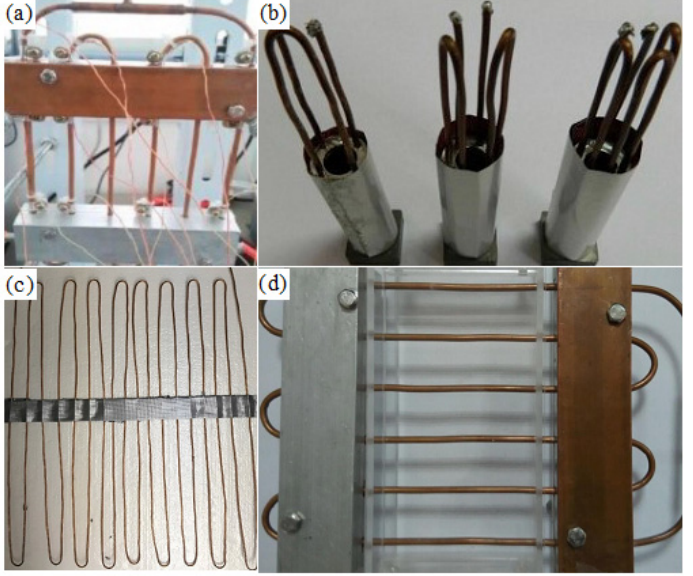
Figure 2. The structure of PHP: ( a ) The CLPHP [52]. Zhao et al. (2016); ( b ) The PHP for cooling metal cutting tools [53]. Wu et al. (2016); ( c ) The PHP for waste heat recovery [54]. Mahajan et al. (2018); ( d ) Copper tube PHP with expanded graphite/graphite [55]. Zhao et al. (2016).